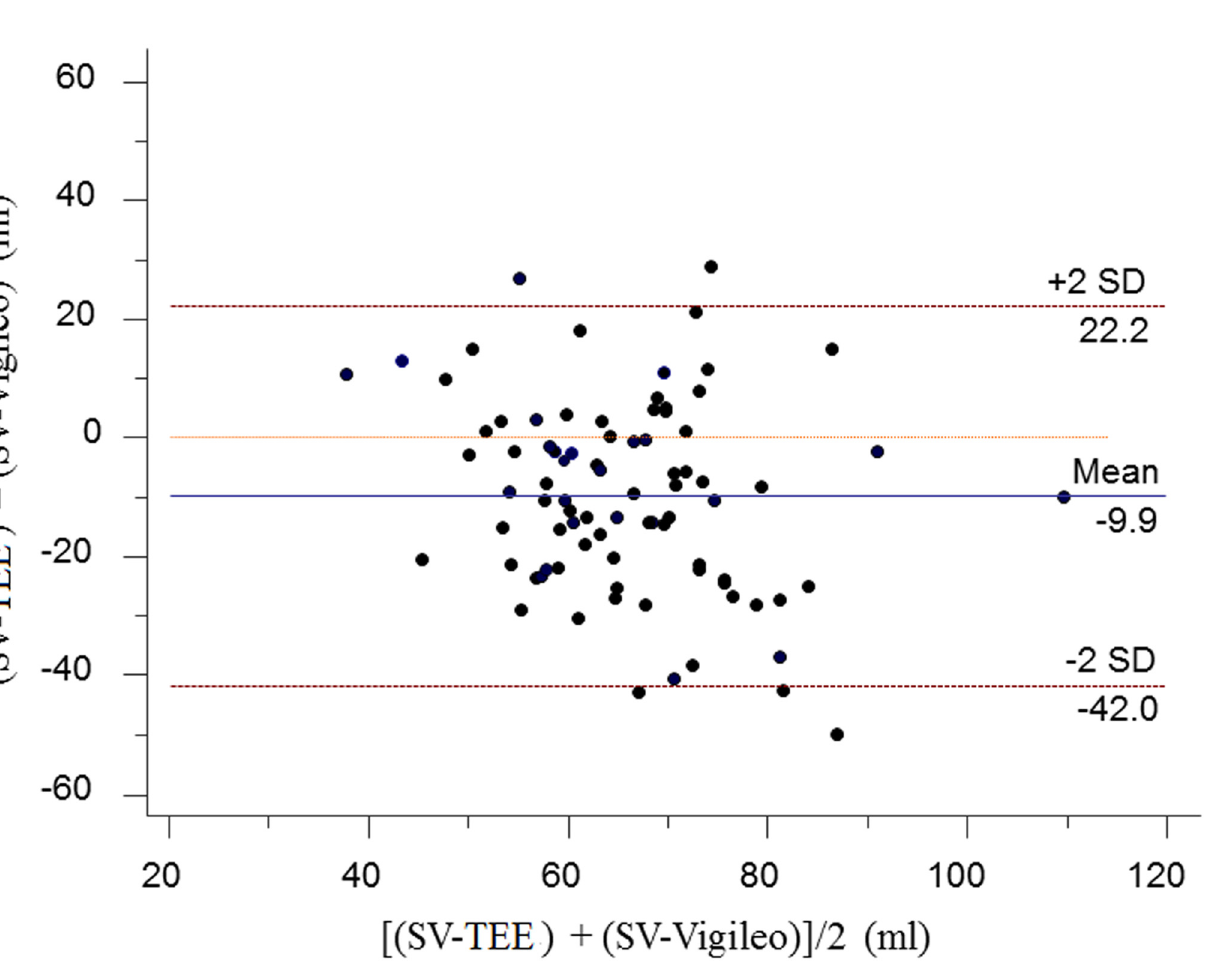
Fig 1. Bland-Altman plot for the difference between the SV-TEE and the SV-Vigileo during pneumoperitoneum combined with the steep Trendelenburg position. SV-TEE, stroke volume measured using transesophageal echocardiography; SV-Vigileo, stroke volume derived by the third- generation FloTrac/Vigileo ™